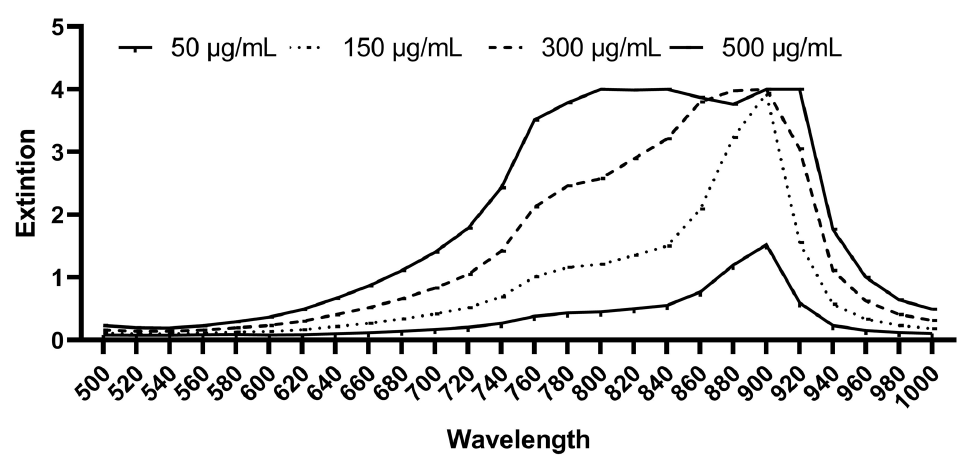
Figure 1. Absorption spectrum of ICG in GC medium at a concentration of 50 µg/mL, 150 µg/mL, 300 µg/mL, and 500 µg/mL (Tecan Infinite ® 200 Reader).